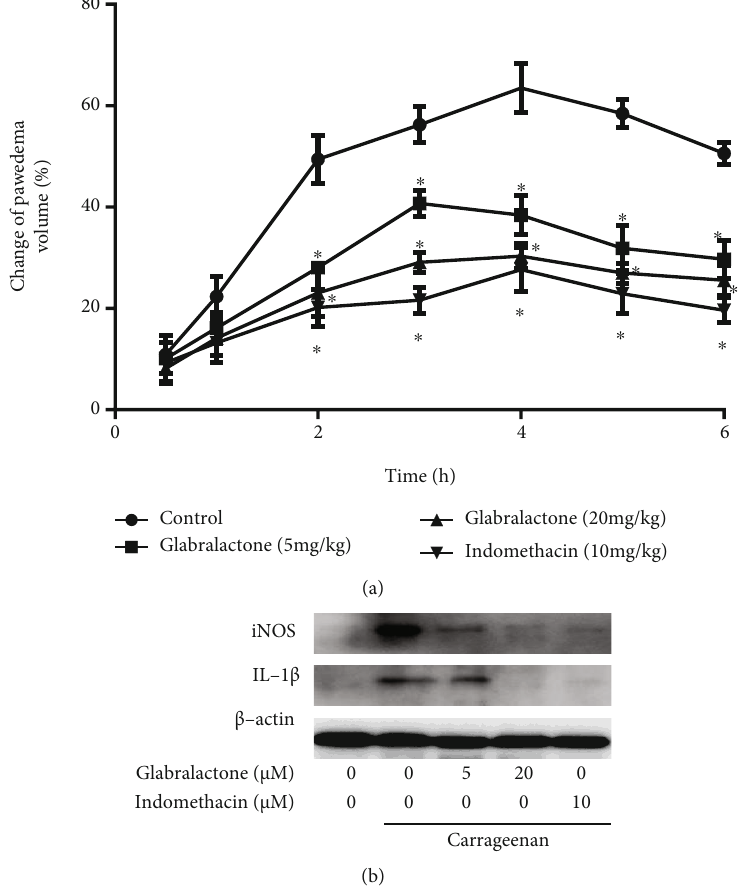
Figure 6: In vivo anti-in fl ammatory activity of glabralactone. (a) Inhibitory e ff ect of glabralactone on the carrageenan-induced paw edema. Glabralactone was orally administered 30 min before subplantar injection of carrageenan. The paw volume was measured at 0, 0.5, 1, 2, 3, 4, 5, and 6h after injection using a plethysmometer. ∗ p < 0 : 05 . (b) E ff ect of glabralactone on the proin fl ammatory protein expression in the carrageenan-induced paw edema model. The soft paw tissues were amputated and homogenized using a nuclear extract kit (Active Motif, Carlsbad, CA). The expressions of iNOS and IL-1 β proteins were examined by Western blotting. β -Actin was used as an internal